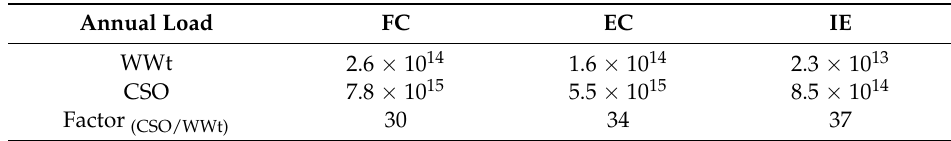
Table 6. Annual load of the Mur River for FC, EC and IE (median) for WWt, combined sewer overflow (CSO), and impact factor WWt/CSO (MPN/100